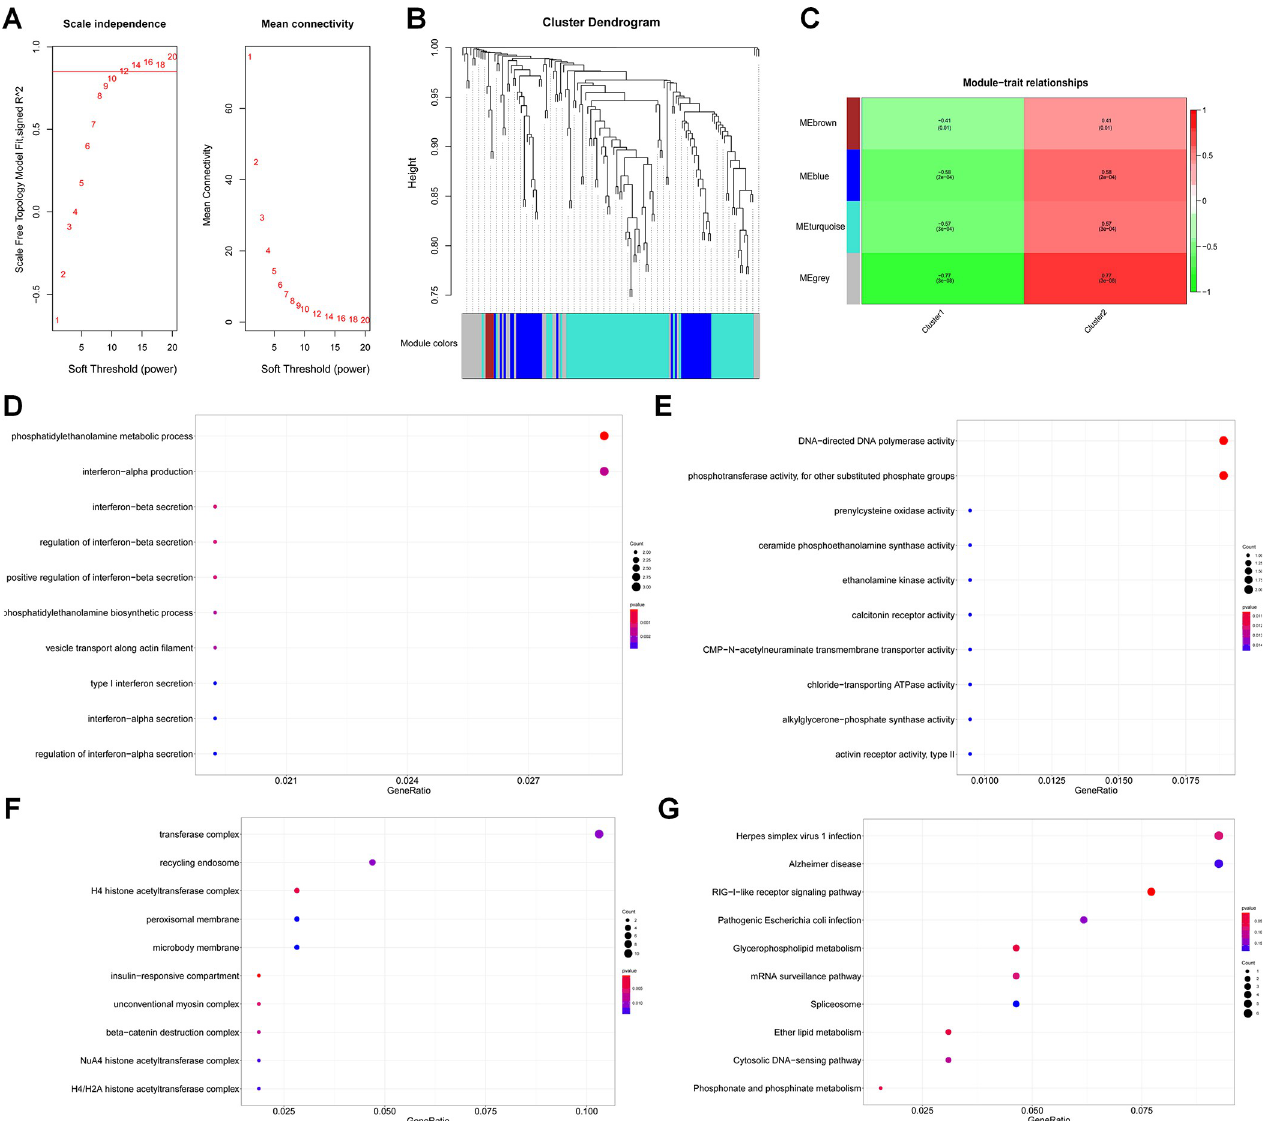
Fig 2. Construction of expression modules by WGCNA package. (A) Analysis of the scale-free fit index for various soft-thresholding powers and analysis of the mean connectivity for various soft-thresholding powers. (B) The cluster dendrogram of genes. Each branch represents one gene, and every color below represents one expression module. (C) Heatmap of the correlation between module genes and the clusters. (D-F) Top 10 terms from a GO analysis of molecular function, biological process and cellular component in the blue and turquoise modules. (G) Top 10 terms were clustered by KEGG pathway analysis in the blue and turquoise